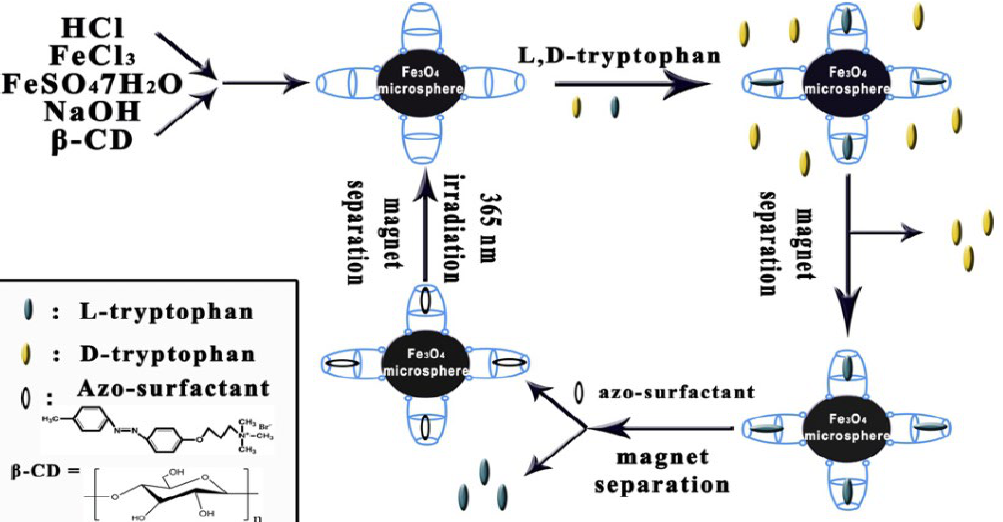
Fig. 13. Preparation procedures and separation mechanism of β-CD modified Fe 3 O 4 nanoparticles for amino acids enantiomers [155]